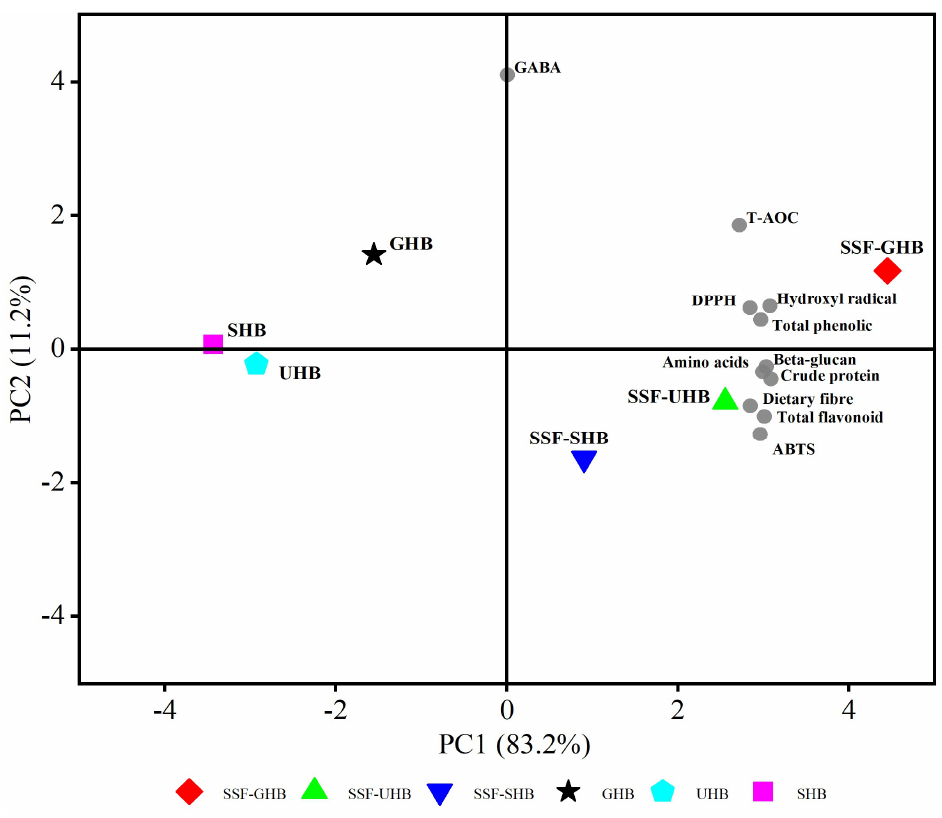
Figure 3. Nutritional constituents and biological activity of highland barley (the control groups and colonized groups with the mycelia of A. sinodeliciosus var. Chaidam ZJU-TP-08) were visualized by principal component analysis (PCA).